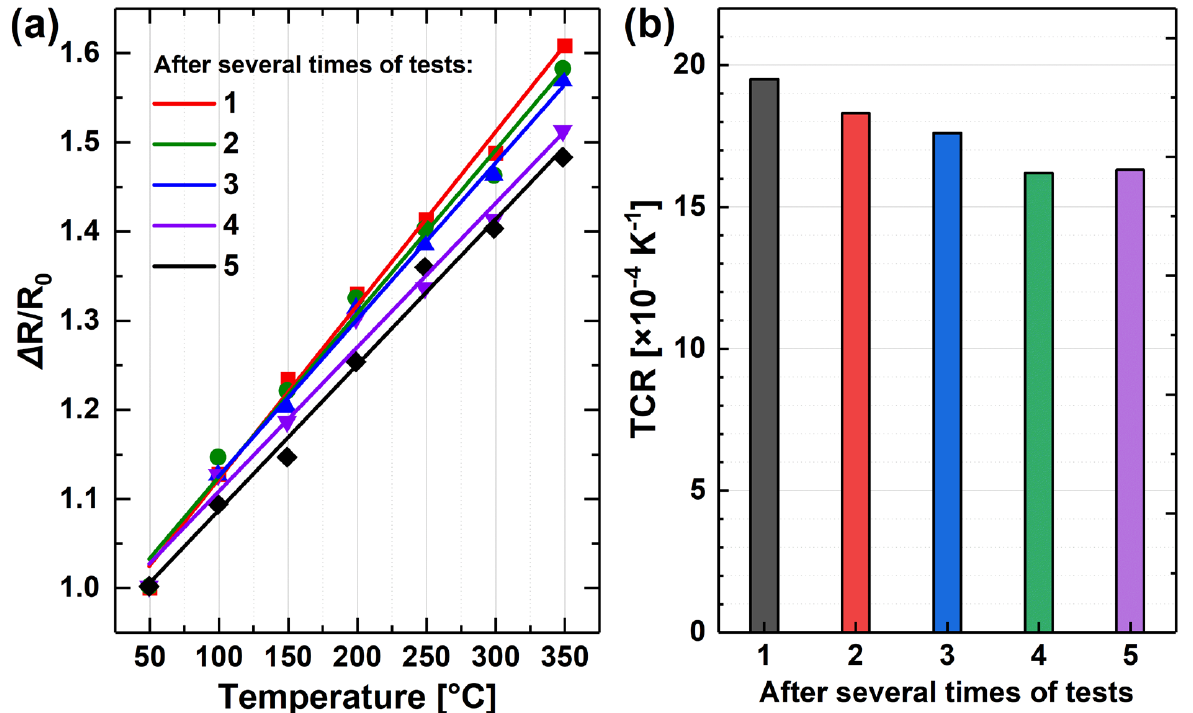
Figure 6. ( a ) Thermal resistance curves and ( b ) TCR values of the WTi alloy film with 6.8 at.% Ti after cycled thermal resistance measurements.